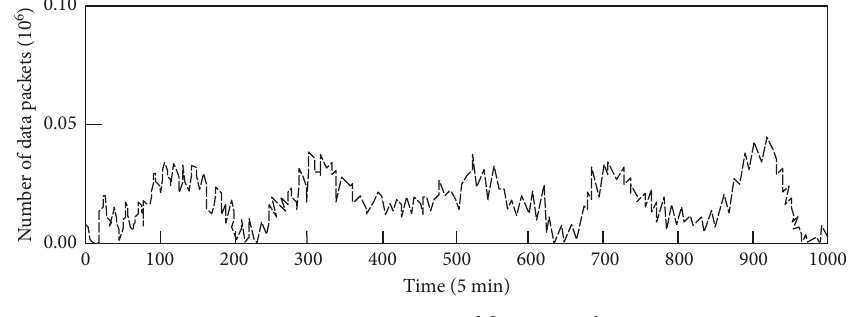
Figure 9: Cross-entropy of flow anomalies.